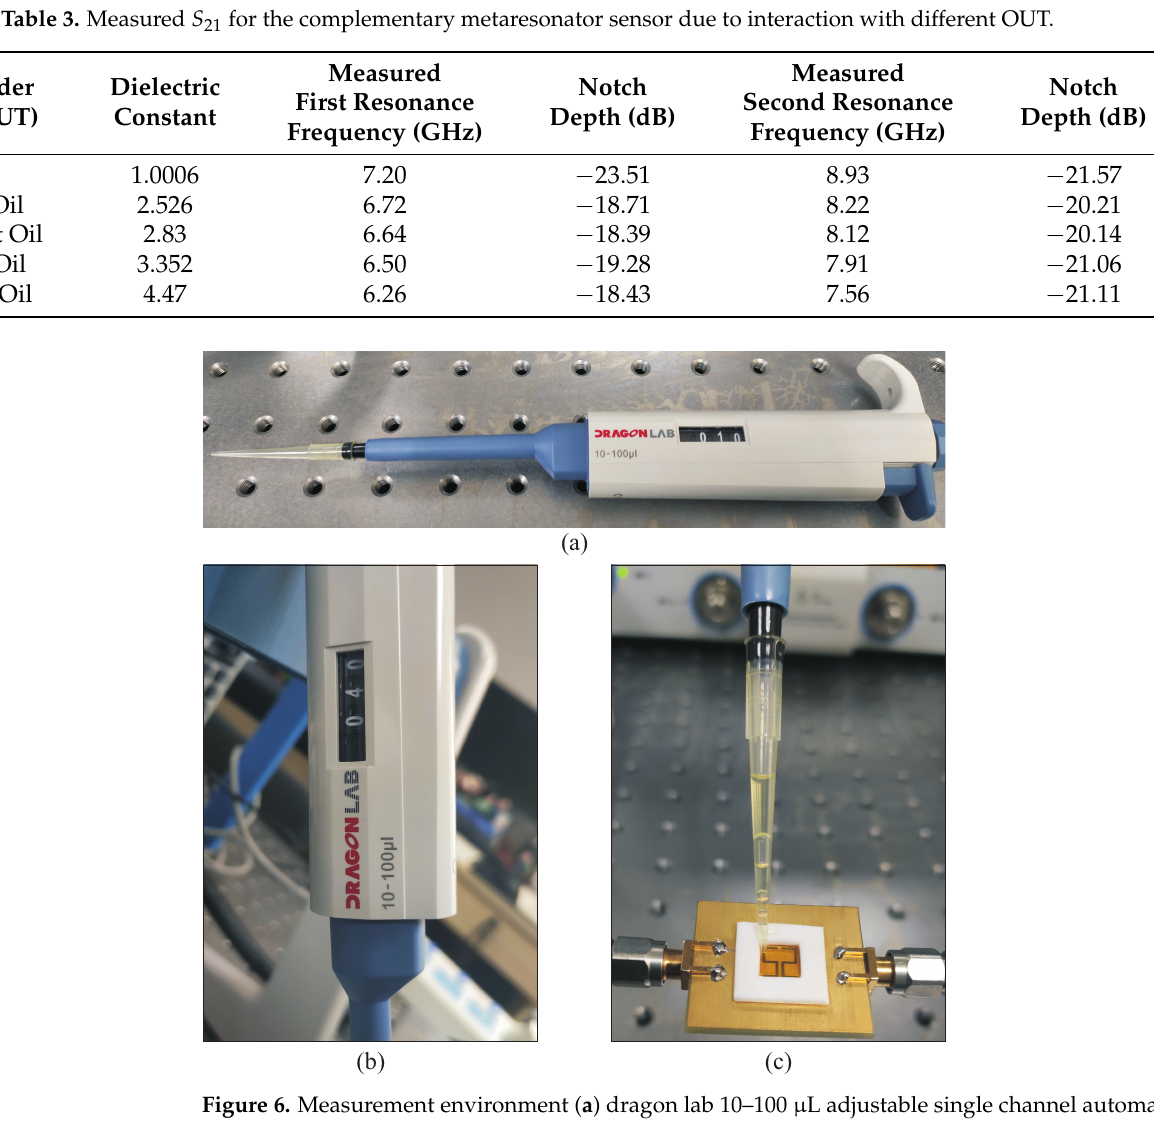
Figure 6. Measurement environment ( a ) dragon lab 10–100 µ L adjustable single channel automatic pipette, ( b ) oil quantity measurement, ( c ) pouring the OUT into the Teflon